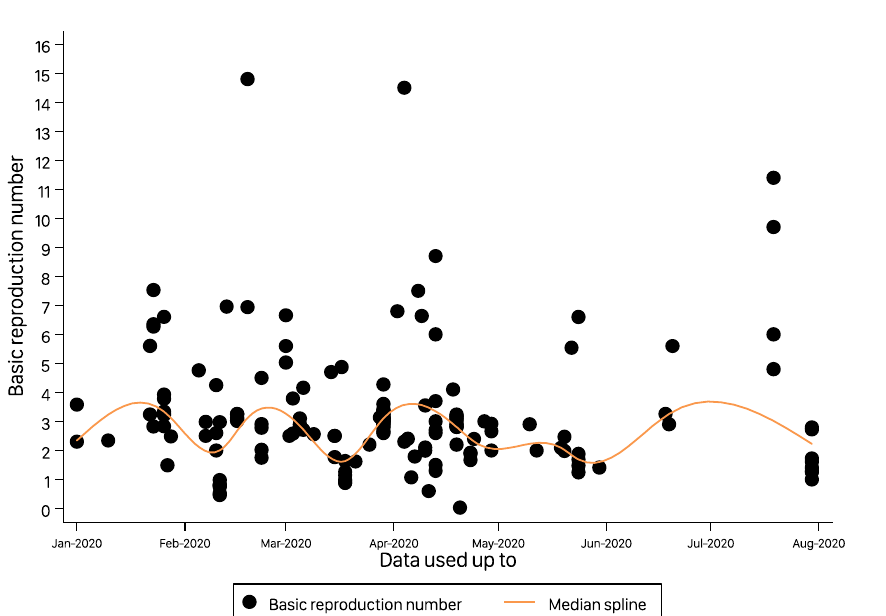
Figure 4. Timeline of the basic reproduction number ( R 0 ) estimates for COVID-19 included in the narrative synthesis.